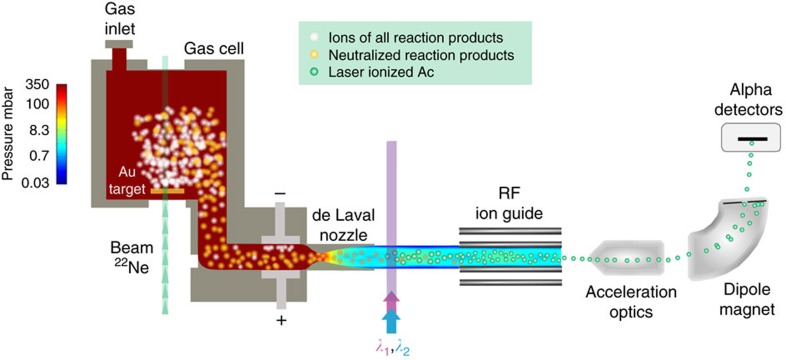
In-gas-jet laser ionization and spectroscopy setup.Short-lived actinium isotopes are produced in the fusion reaction of accelerated neon ions on a gold target. After thermalization and neutralization in purified argon, the actinium atoms are evacuated out of the gas cell through a de Laval nozzle. Just before the nozzle, an electric field is created to collect the remaining ions by applying a DC voltage on a pair of electrodes indicated by a + and a − sign. The resulting collimated supersonic gas jet at Mach ∼6 provides a quasi-collisional free environment at a low temperature (T∼30 K). The gas jet, containing the reaction products, is overlapped with the laser beams to resonantly ionize actinium. The ions are subsequently sent out from the gas cell chamber towards the mass separator through a radiofrequency (RF) ion guide and their decay radiation is finally recorded. The pressure conditions (colour code on a logarithmic scale) range from 350 mbar in the gas cell to the 0.03 mbar background pressure in the gas cell chamber. The setup is not shown to scale.